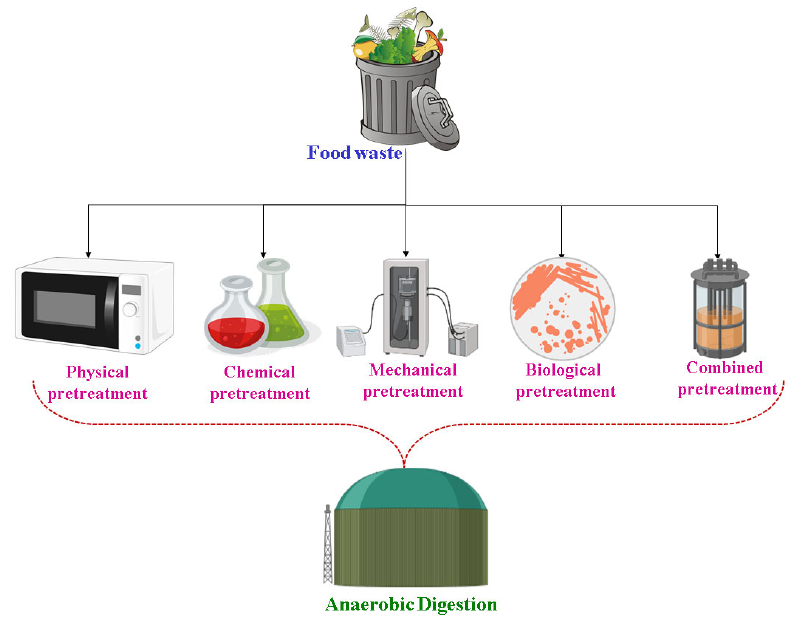
Figure 3. Pretreatment methods to enhance the AD process.